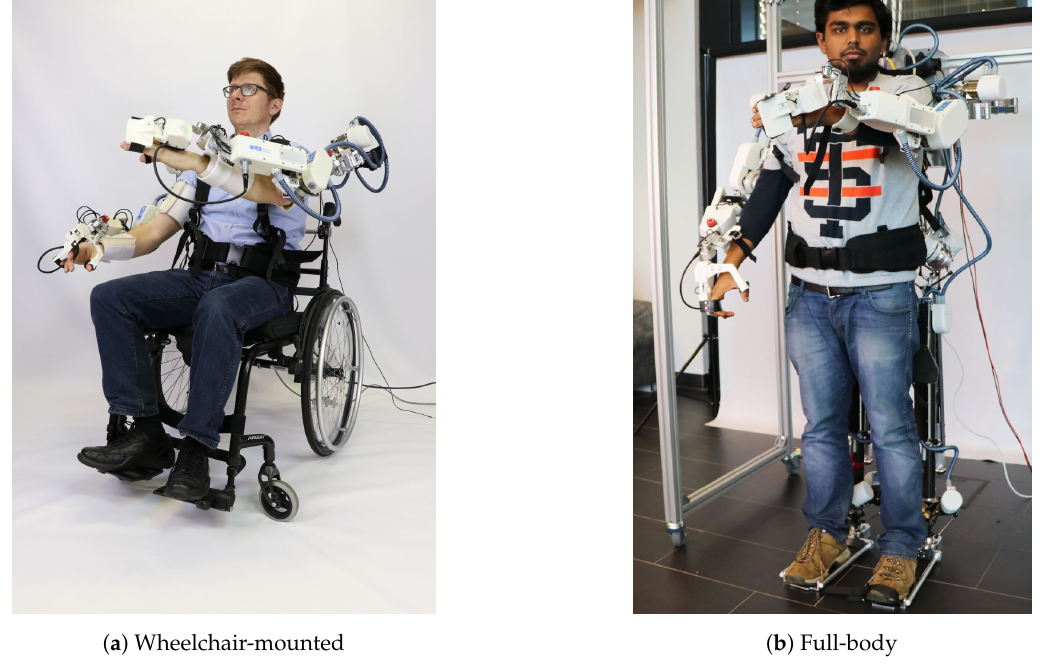
Figure 1. R ECUPERA Exoskeleton system